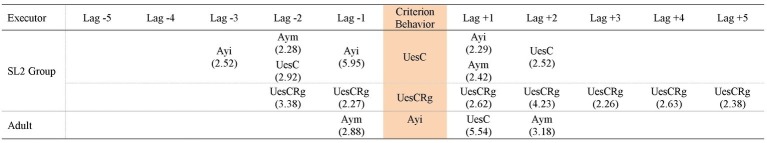
Prospective and retrospective patterns obtained in SL2 group. Post intervention task.